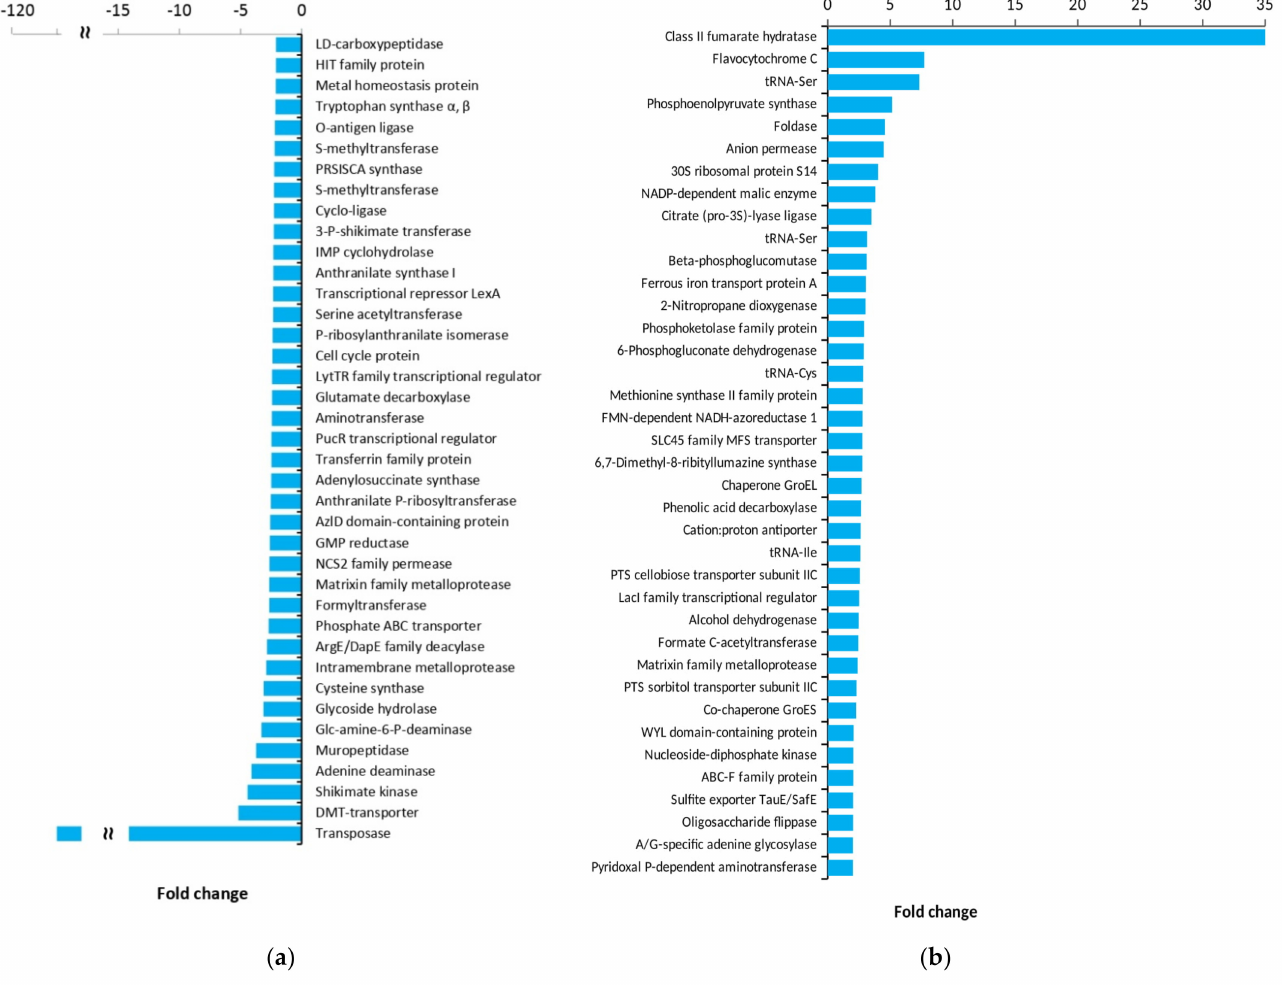
Figure 4. Unique DEGs in L. plantarum strain Ym1. ( a ) Downregulated genes; ( b ) upregulated